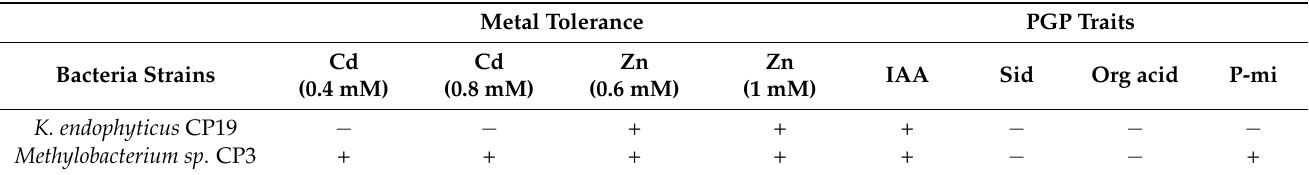
Table 1. Trace element tolerance and in vitro plant growth promotion (PGP) traits of Kineococcus endophyticus CP3 and Methylobacterium sp. CP19. + = positive response; − = negative response. Metal Tolerance PGP